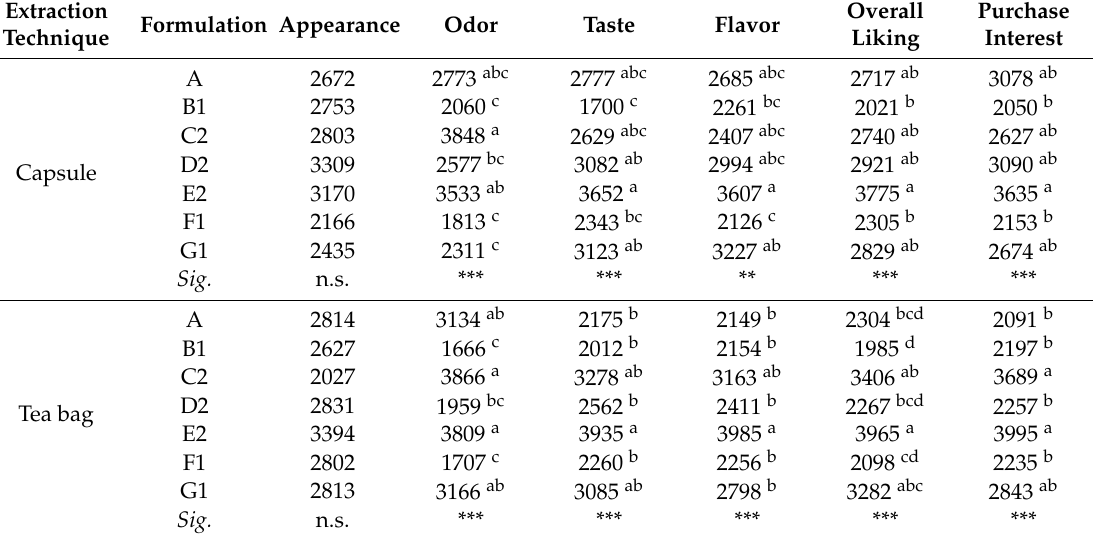
Table 2. Results of Kruskal–Wallis test (reported as sum of ranks) of consumer acceptance evaluation and results of the multiple comparison